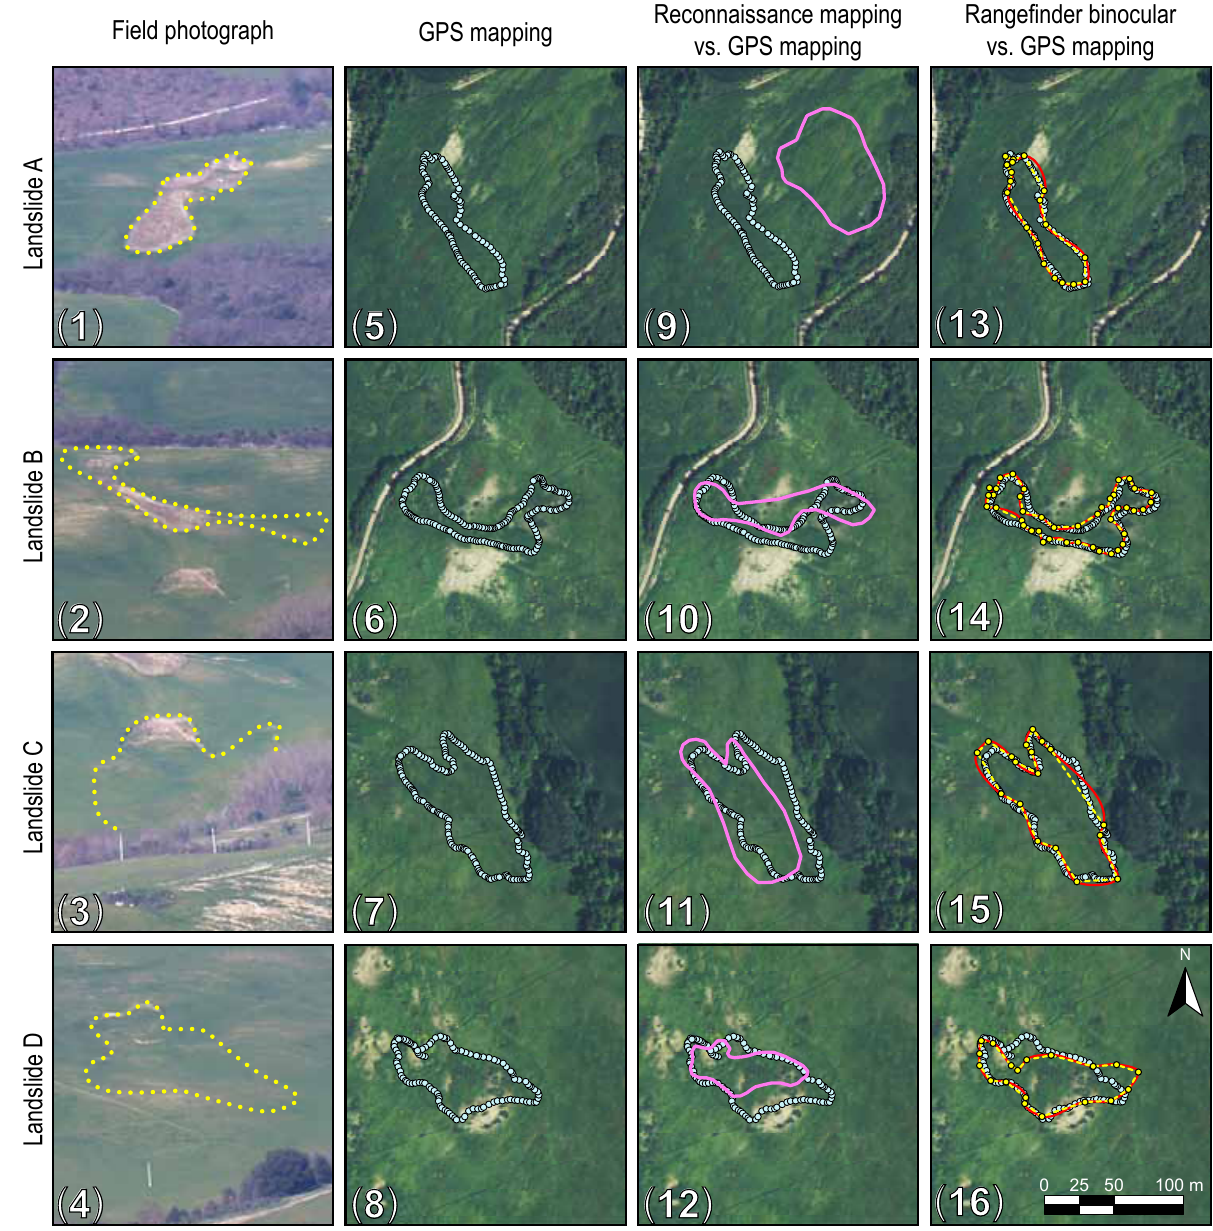
Fig. 3. Comparison of landslide maps prepared for four landslides in the Monte Castello di Vibio area, Umbria, Central Italy. From left to right, columns show: (i) photographs taken in the field to help the visual reconnaissance mapping (dotted yellow lines added to outline the landslides), (ii) maps obtained by walking the GPS receiver along the perimeter of the individual landslides, (iii) maps portraying the result of the visual reconnaissance mapping (violet lines) and mapping obtained by walking the GPS receiver along the landslide perimeter (light blue dots), (iv) maps obtained using the rangefinder binocular and GPS (yellow dashed lines show raw data obtained in the field, and red lines show smoothed landslide boundaries for improved cartographic appearance) and mapping obtained by walking the GPS receiver along the landslide perimeter (light blue